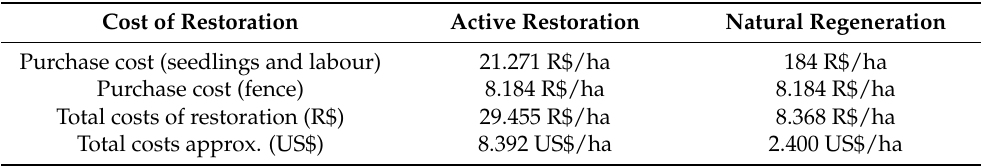
Table 3. Comparison of the average costs of restoration strategies. The exchange rate during the implementation period (2006) was R$